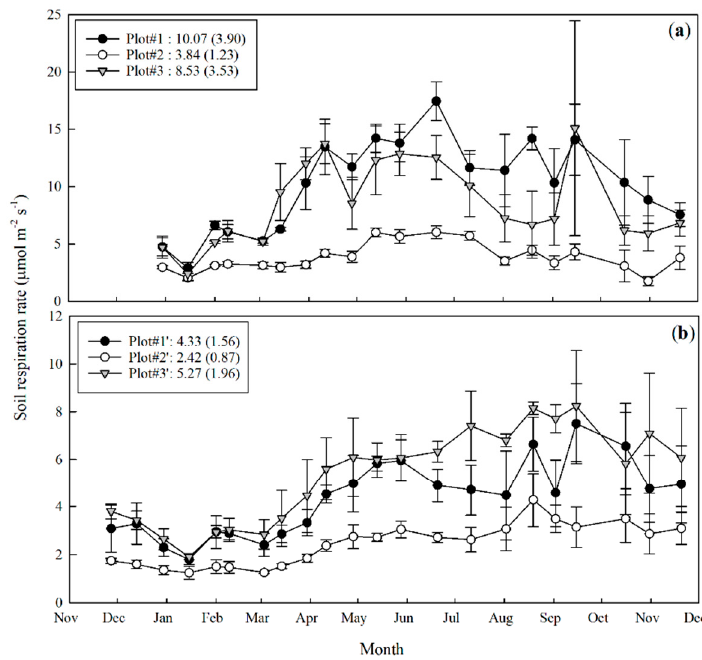
Figure 5. Soil respiration rate of the paired plots in control ( a ) and trenching treatment ( b ). Plot #1 and Plot #1 ′ are paired plots in forest gap; Plot #2 and Plot #2 ′ are paired plots in upper slope; Plot #3 and Plot #3 ′ are paired plots in lower slope valley. Error bars represent the standard deviation.